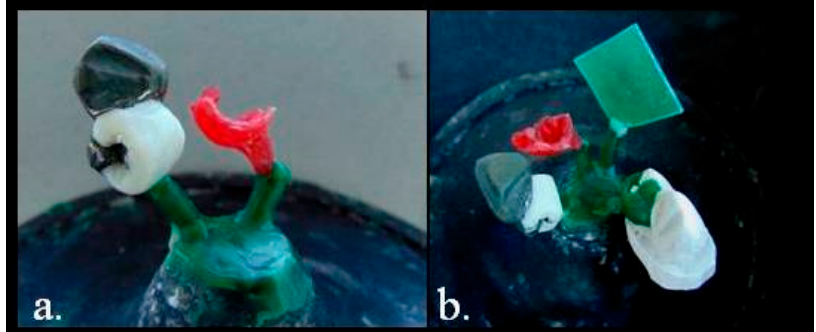
Figure 10. ( a ). The Mb + wax model and the Pa framework, Mb- resin model, prepared for coating by connecting the casting channels to the model; ( b ). The DMb wax model ready for coating together with the refractory duplicate.